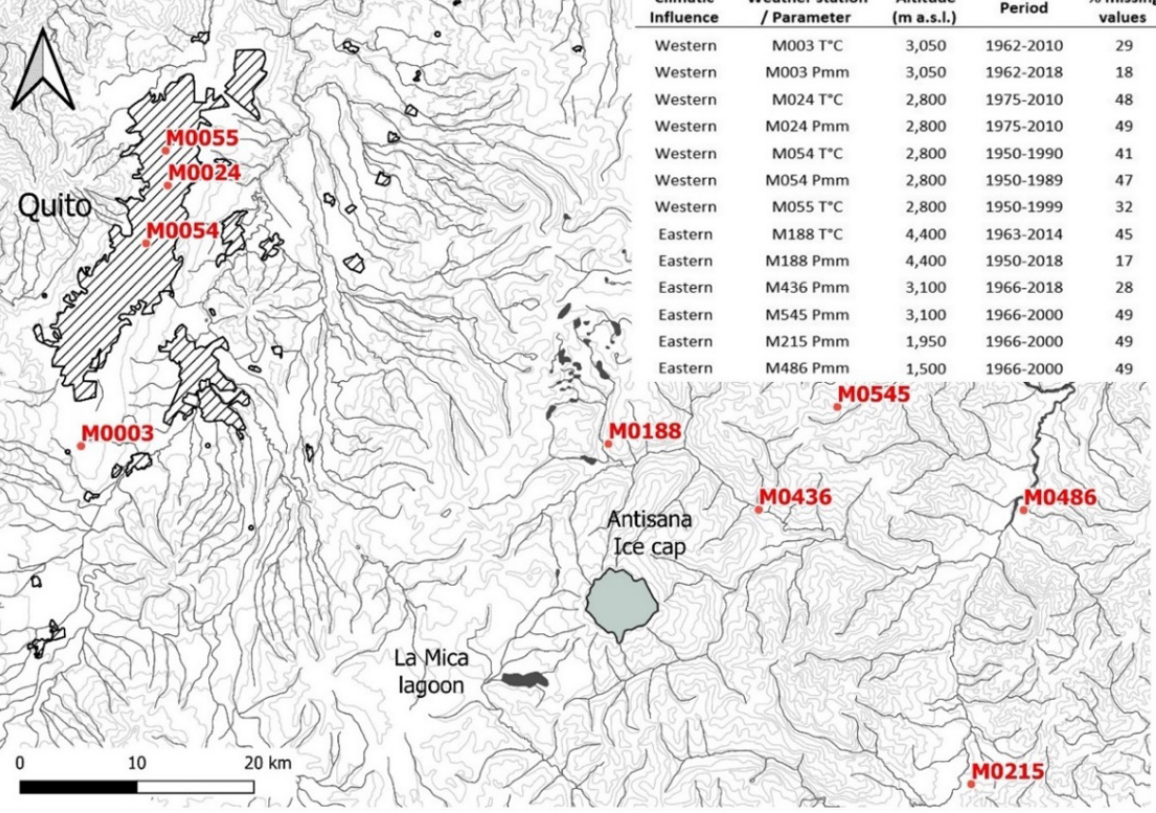
Figure 2. Map of long-term weather stations located in the region. The city of Quito and the ice cap are represented by the hatched and solid grey polygons, respectively. The inset table lists the meteorological stations and the variables used in this study; the percentage of missing values at a monthly time step are reported. Cartographic information was provided by the Instituto Geográfico Militar of Ecuador (IGM). Table 3. Temperature ( T , ◦ C) and precipitation ( P , mm) datasets used in this study. The mean difference and the RMSE between observations and reanalysis before bias correction and quantile mapping (bBC/QM) and after correction (aBC/QM). Influence Weather station % missing Mean diff. Mean diff. RMSE RMSE